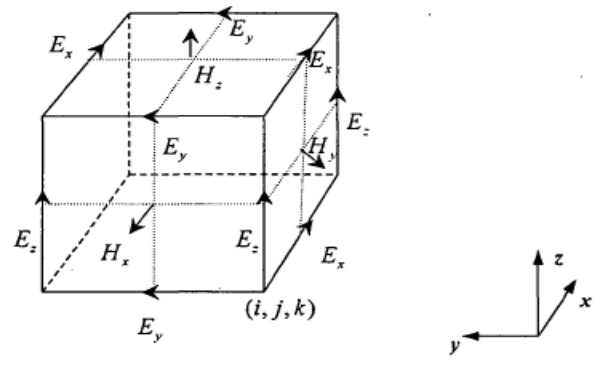
Figure 1: Yee cells in FDTD